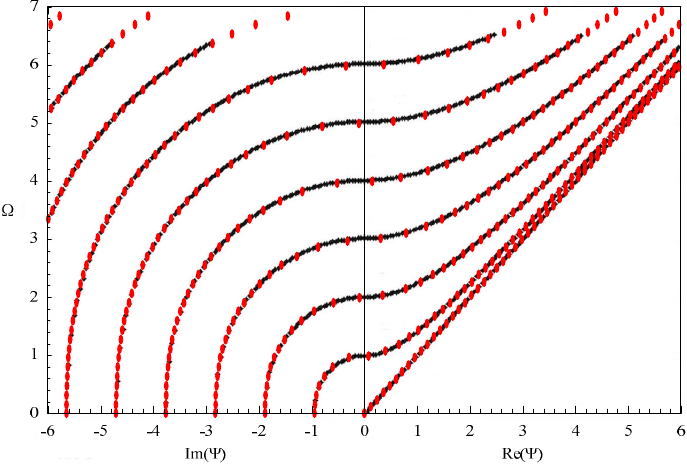
Figure 3. Dispersion curves of the shear horizontal (SH) wave in a piezoelectric plate; red dotted lines—our results, black ones—literature results.